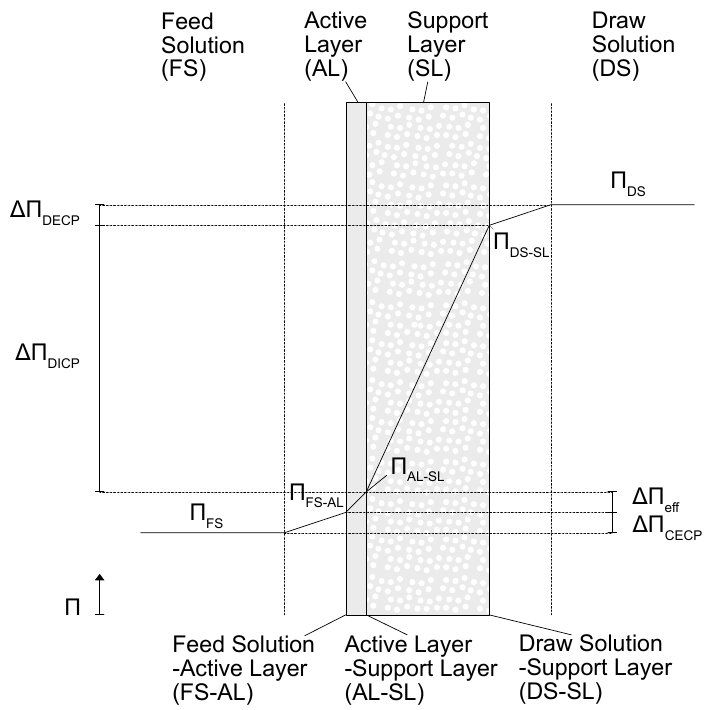
Figure 2. Scheme of material transport for a given membrane location [24,25].